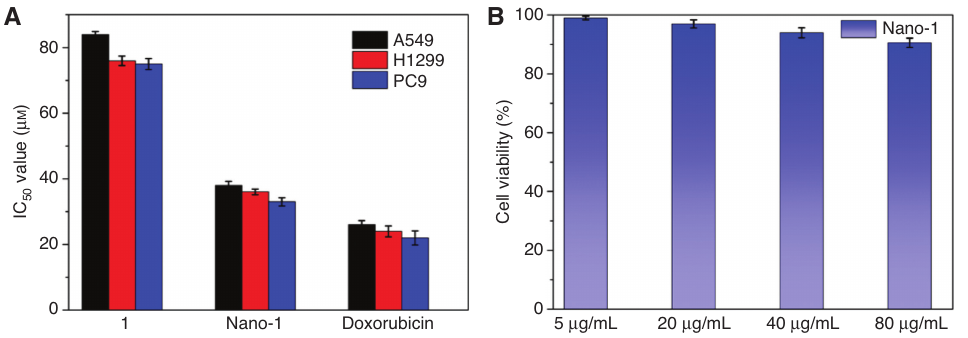
Figure 4: The MTT assay results for compound 1